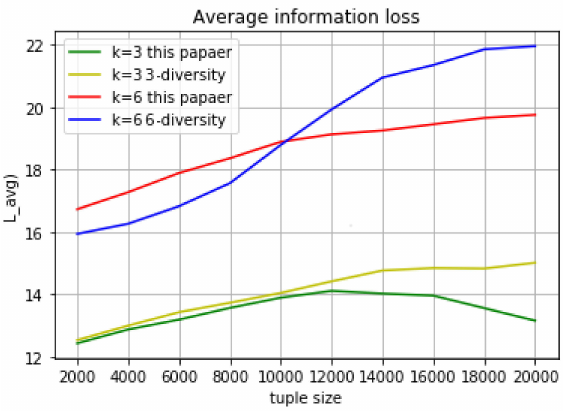
Figure 2. Average information loss.